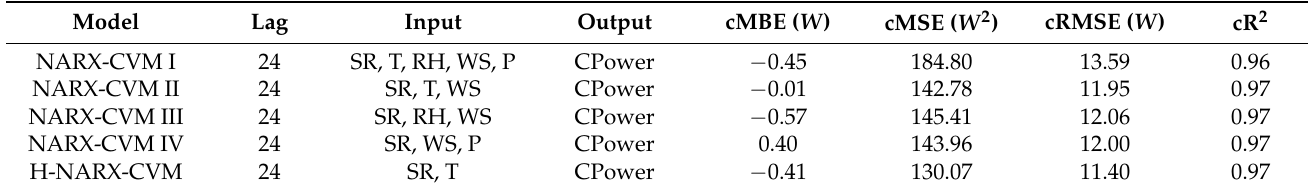
Table 9. Performance test results after applying the corrective vector